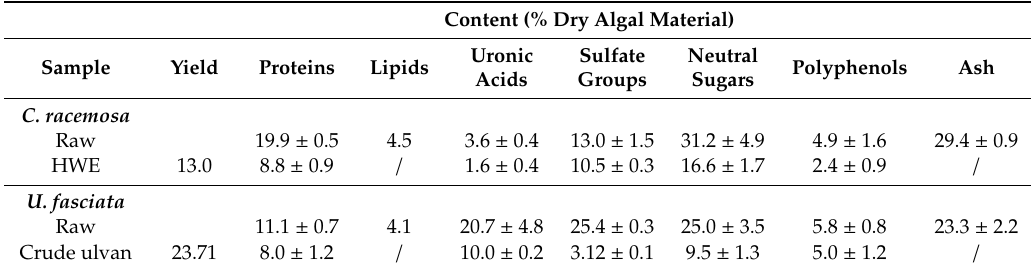
Table 1. Biochemical composition (% of dry weight) of raw and purified fractions from Caulerpa racemosa and ulvan from Ulva fasciata